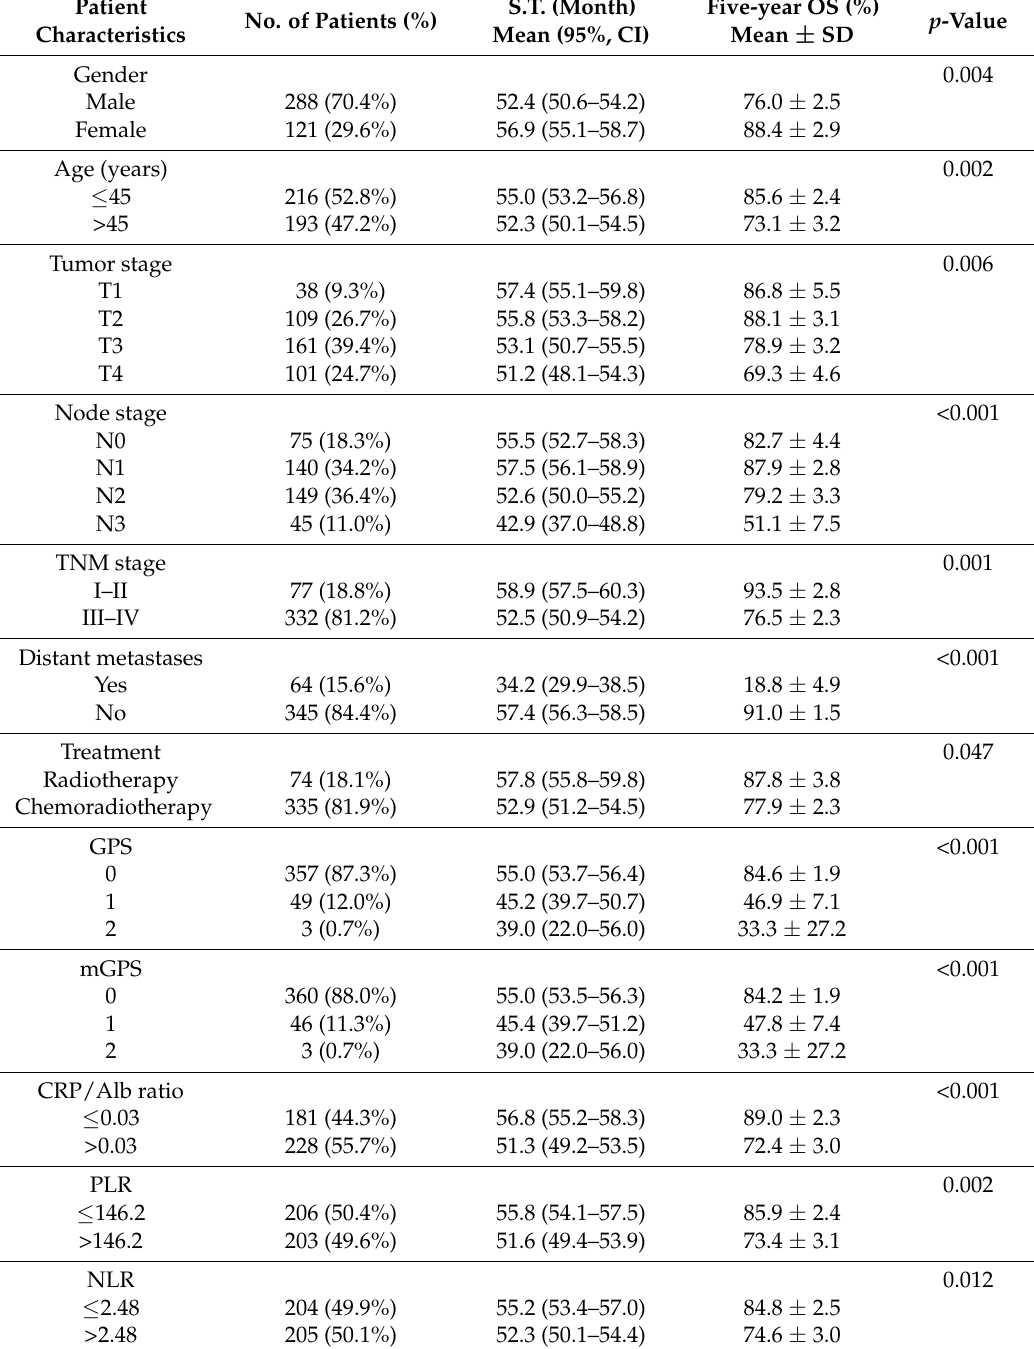
Table 1. Univariate analyses of clinical and laboratory characteristics of survival time (S.T.) and the five-year overall survival